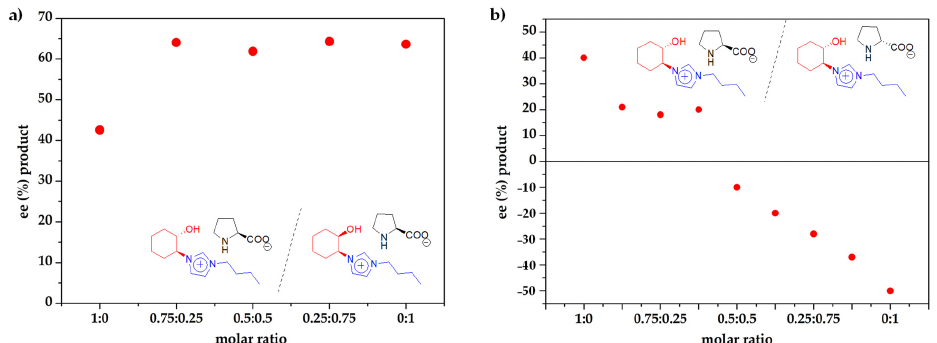
Figure 6. ( a ) Influence of the configuration at the C-OH carbon of the imidazolium cation on the enantioselectivity observed. ( b ) Influence of the configuration at the prolinate anion on the enantioselectivity observed towards the R aldol product. Conditions: rt, 23 h; 1:10 aldehyde( 1 ):acetone( 2 ) ratio; constant concentration of catalyst (0.55 M). Table 4. Results for the aldol reaction between p -nitrobenzaldehyde and cyclohexanone using different prolinates (40% catalyst loading) at room temperature in the absence of solvent 1 .